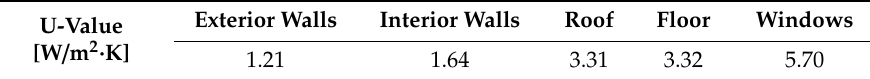
Table 1. Thermal transmittance of the building’s constructive elements.